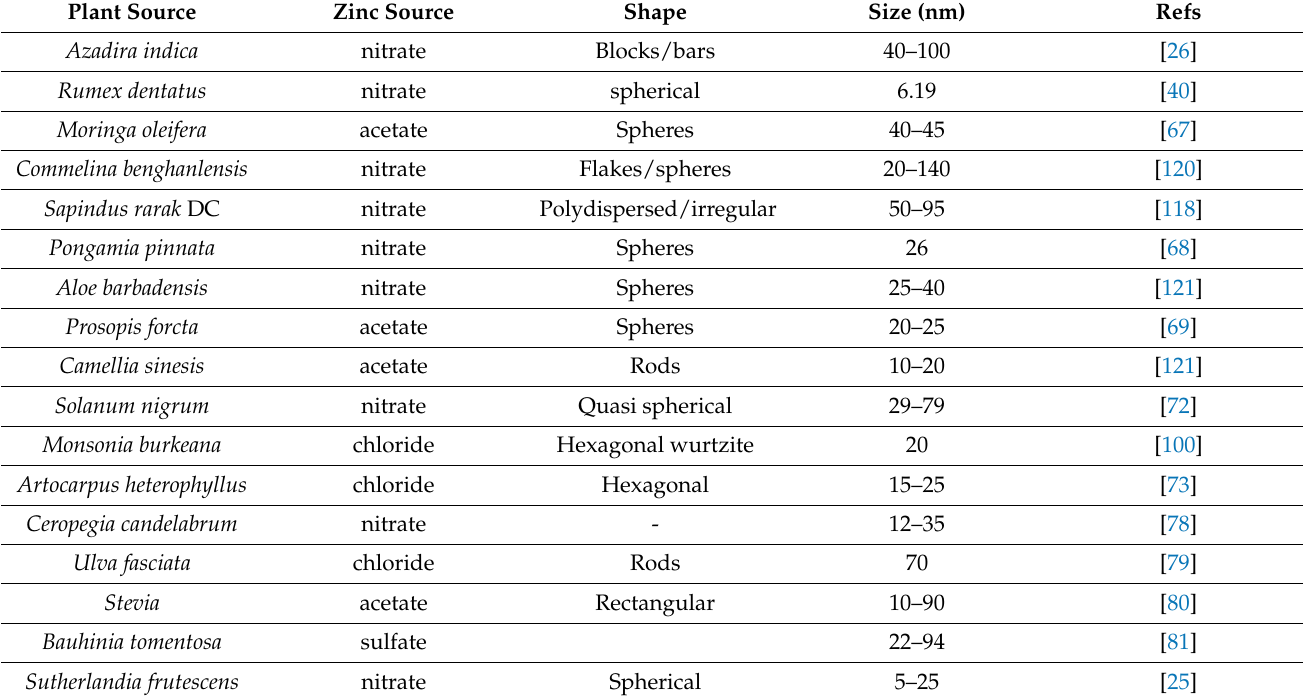
Table 3. Various plants used to synthesise ZnO